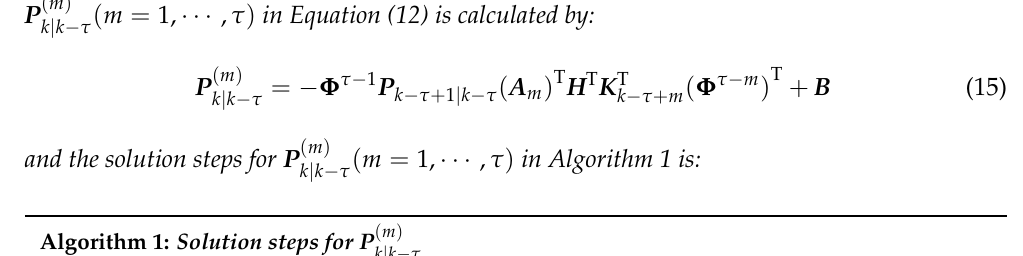
Algorithm 1: Solution steps for P